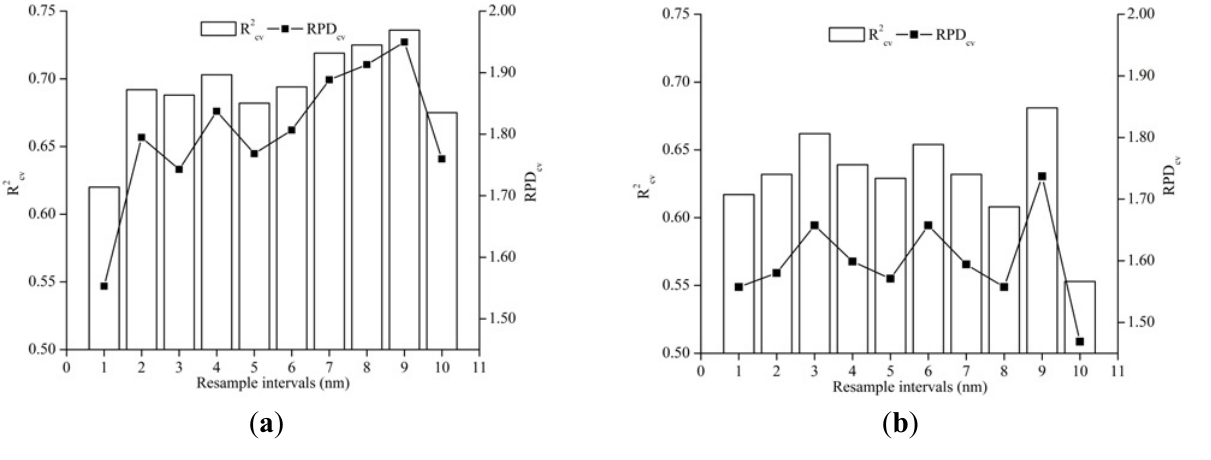
Figure 2. Resample interval selection based on the leave-one-out cross-validation results of support vector machine regression (SVMR) ( a ) and partial least squares regression (PLSR); ( b ) models. R 2 is the coefficient of determination between the measured and estimated CV values of cross-validation. RPD is the residual prediction deviation of cross-validation. CV